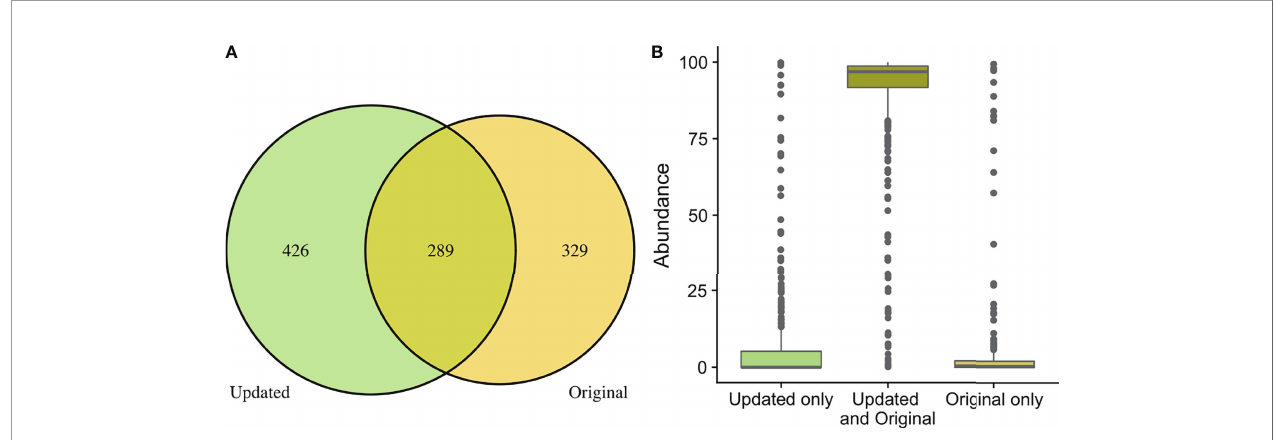
FIGURE 3 | Comparison of taxa recovered through original and updated processing. OTU tables from the original study were obtained and compared to data generated from ASV tables after repeat processing. (A) depicts the number of individual genera that were identi fi ed after the original and updated processing pipelines. There were 329 and 432 unique genera identi fi ed with the original and updated pipelines, respectively. A total of 289 genera were identi fi ed with both processing pipelines. (B) shows the relative sequence abundances of those identi fi ed with only original or updated processing, as well as those identi fi ed with both pipelines. As depicted, the unique genera that are only identi fi ed in the original or updated pipelines tend to be low abundance sequences, while the large majority of the highly abundant sequences were identi fi ed through both processing